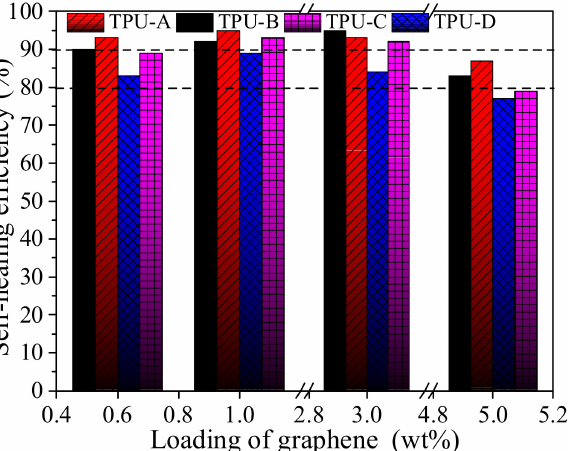
Figure 16. Self-healing efficiency of the composite films prepared with TPU-A, TPU-B, TPU-C and TPU-D, with different graphene loadings, respectively.